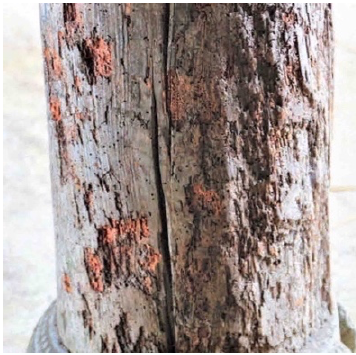
Figure 4 . Column attacked by beetles